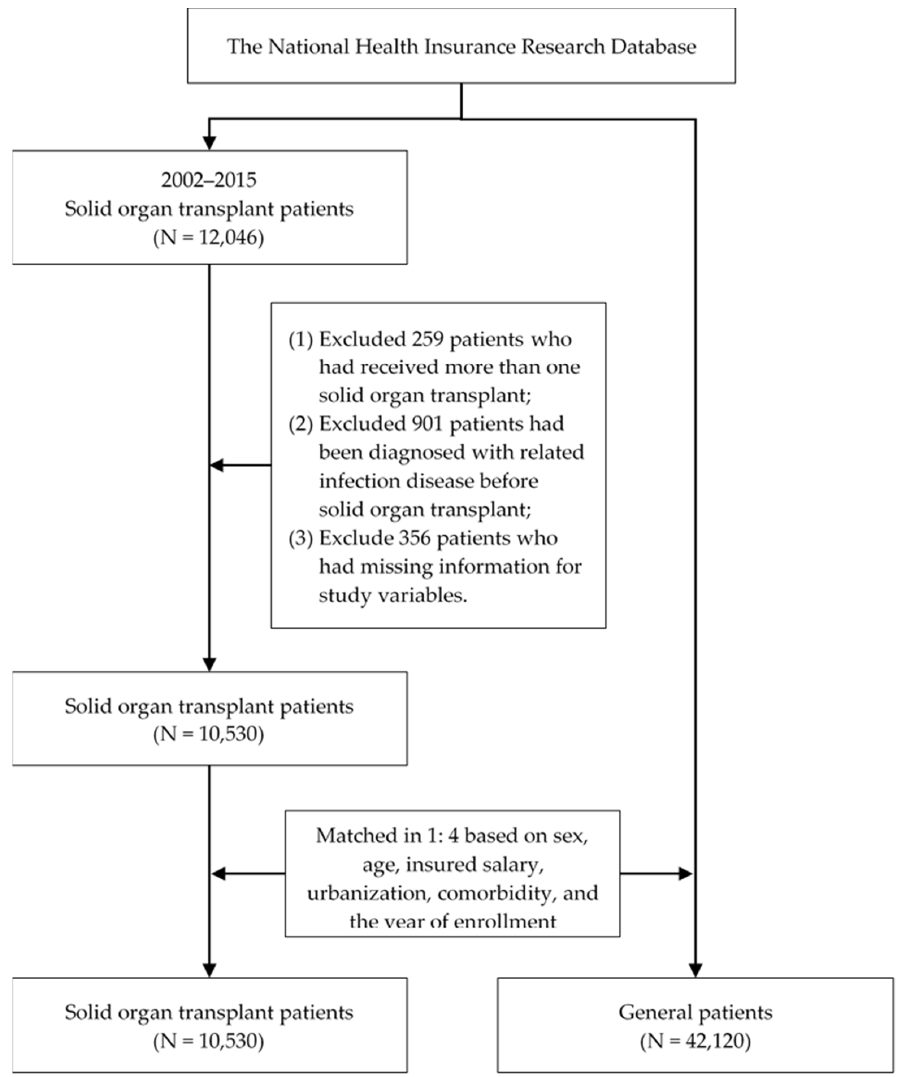
Figure 1. The flow of participant selection.